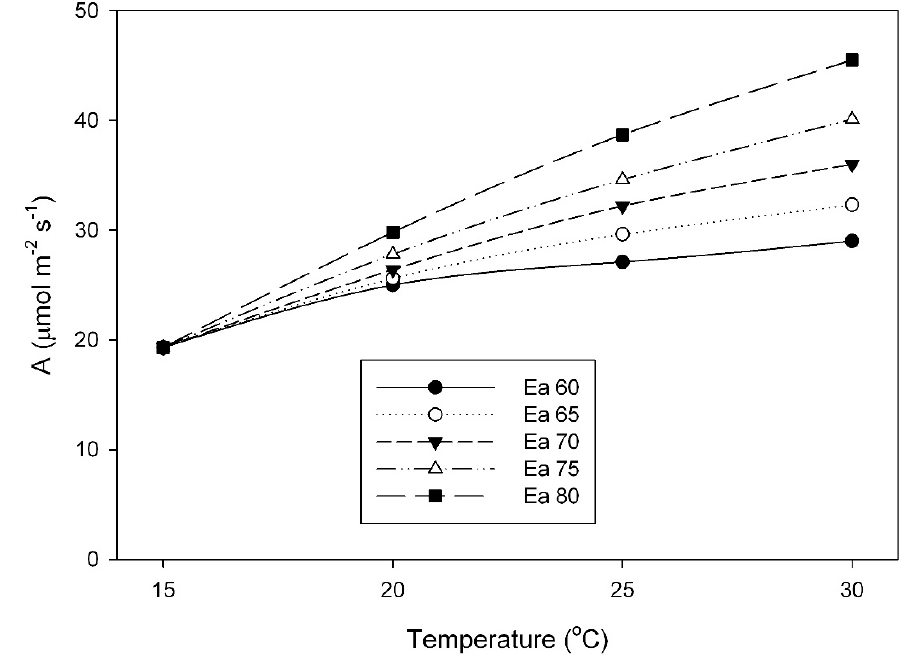
Figure 6. Hypothetical rates of A at the CO 2 concentration at Rubisco (C c ) = 250 μ mol mol –1 , for a single value of V Cmax at 15 °C, combined with different activation energies (Ea, in kJ mol –1 ) of V Cmax of Rubisco.